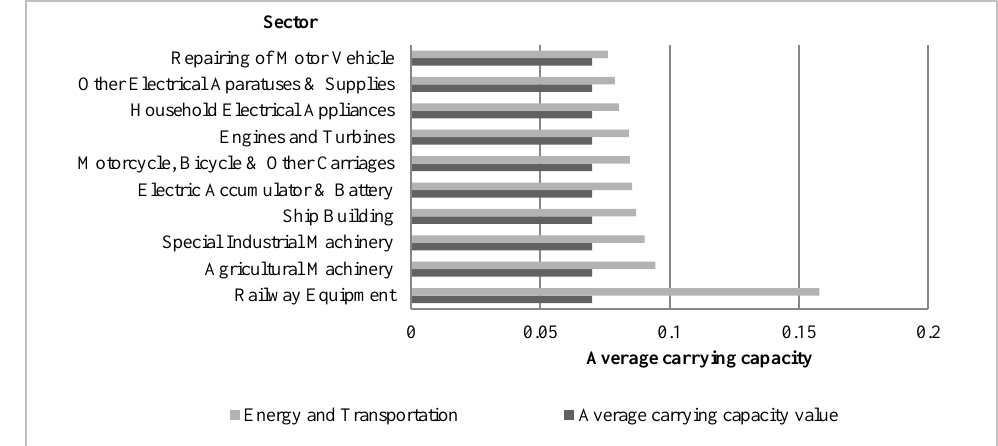
Fig. 4. Energy and Transportation Cost.